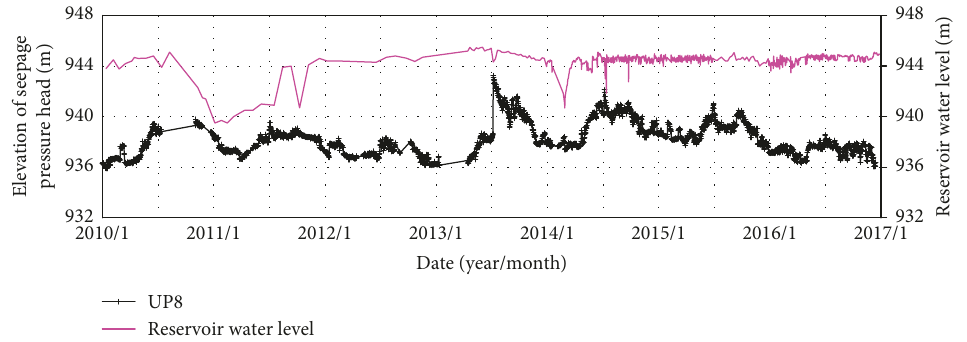
Figure 12: Time series for seepage pressure head at UP8 and reservoir water